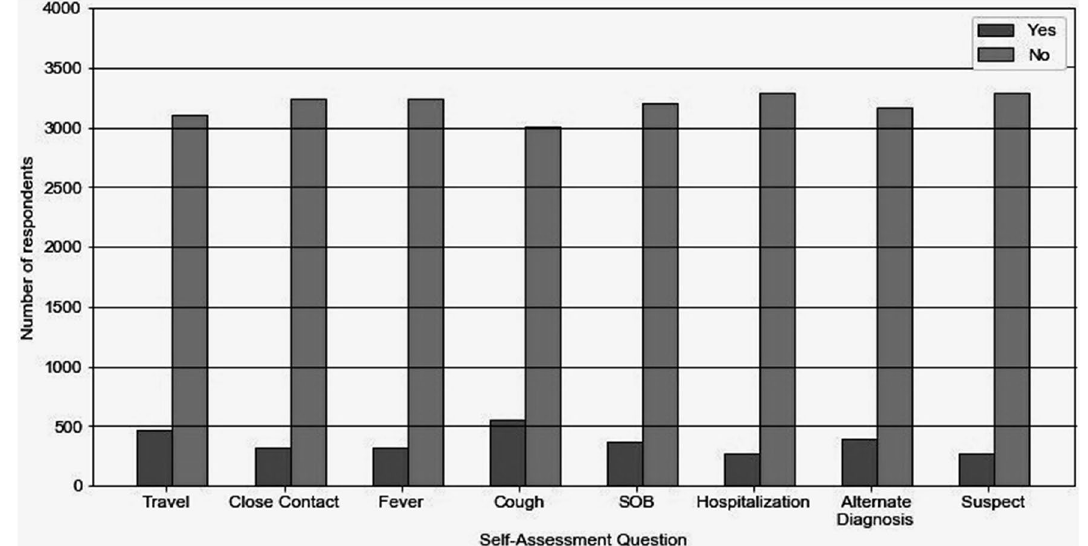
Figure 7. Analysis of self assessment. A simple user-level self-assessment has been deployed to enable the general population to perform self-assessment and identify the population at risk, which can be used as an effective screening. A higher trend for a positive COVID-19 report in people who reported cough was observed. The symptoms of the disease have been known to change with strains, hence this approach of crowdsourcing information provides an agile approach to screen patients with specific